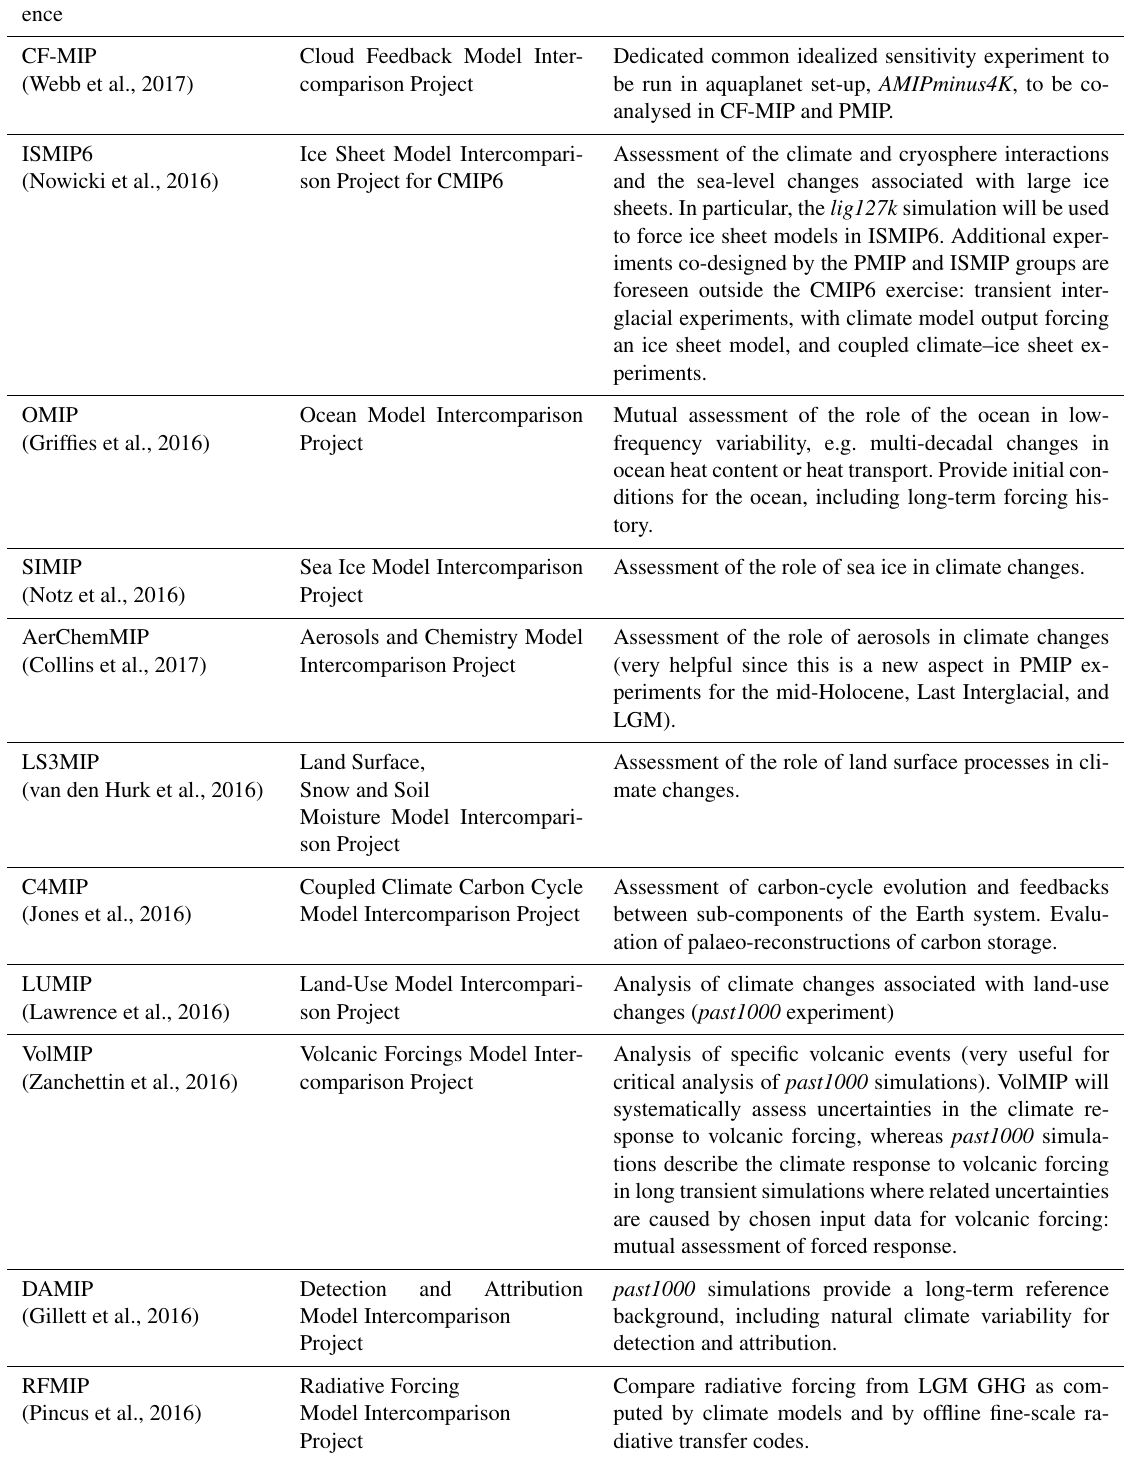
Table 4. Interactions of PMIP and other CMIP6